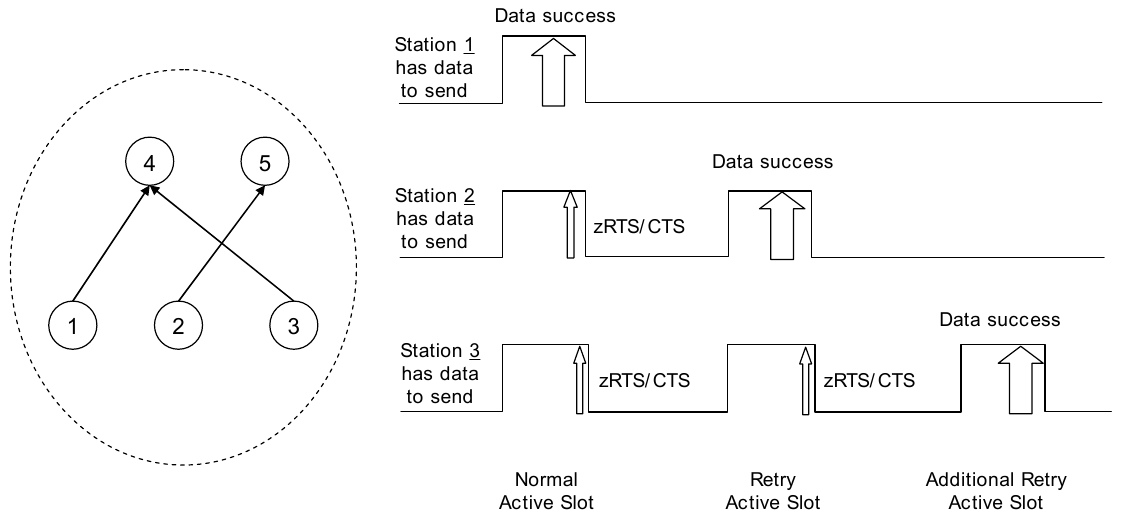
Figure 4. Retransmission procedure between parent and child nodes along the tree using more bit in DATA frame or zero RTS